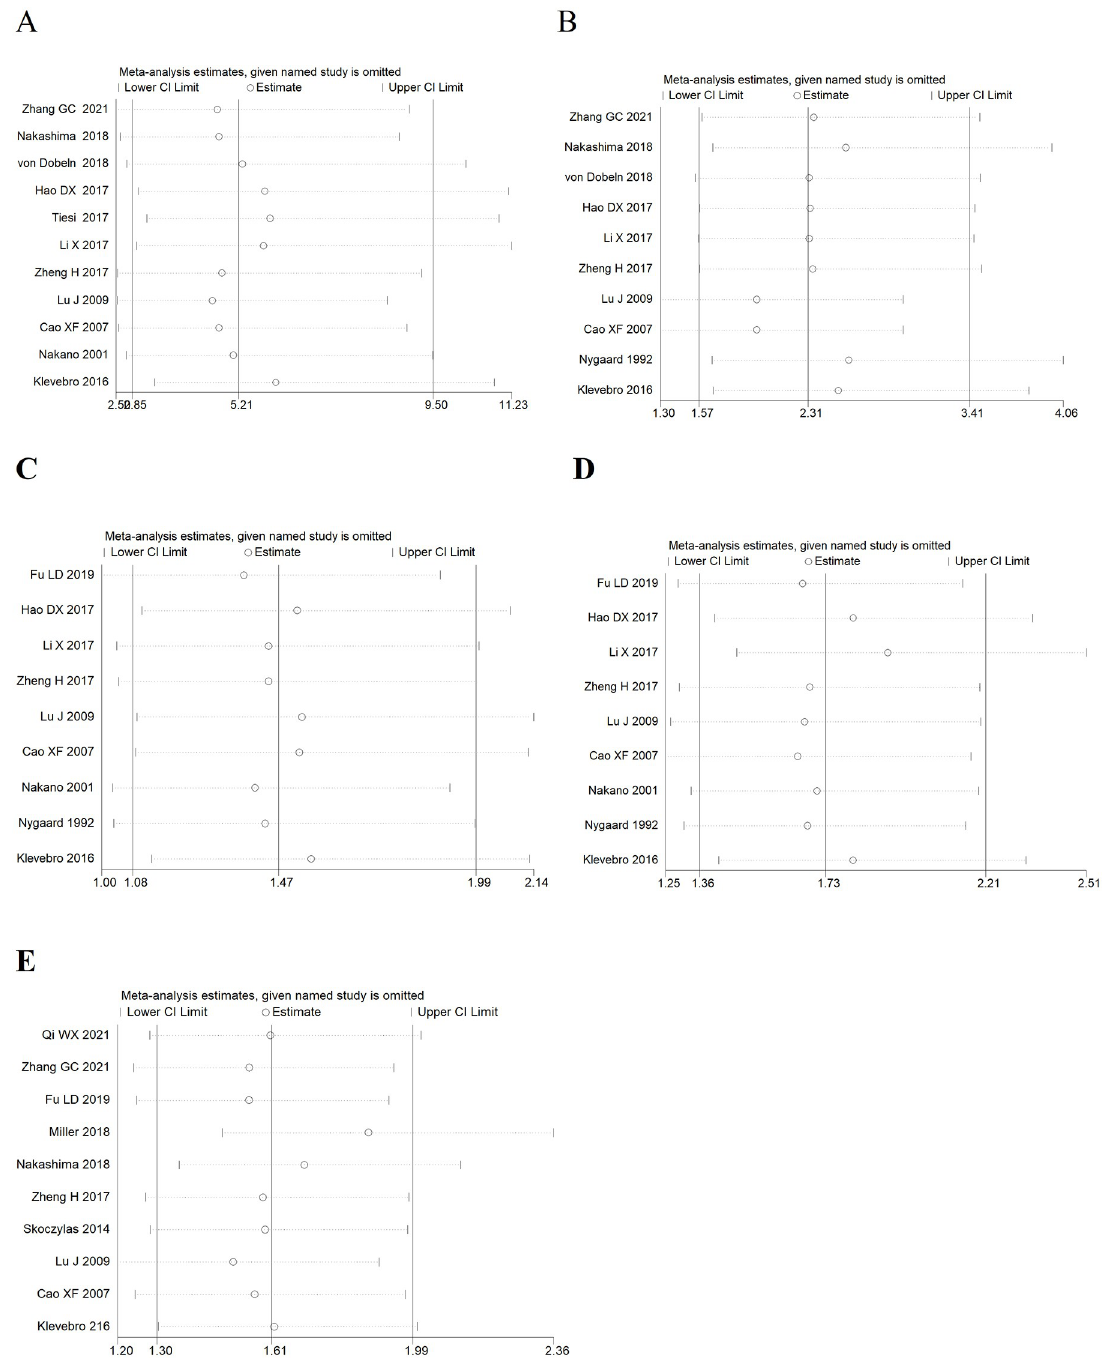
Fig 7. Sensitivity analysis of pCR (A), R0 resection (B), 1-year survival rates (C), 3-year survival rates (D) and 5-year survival rates (E) of NCRT group and NCT group.